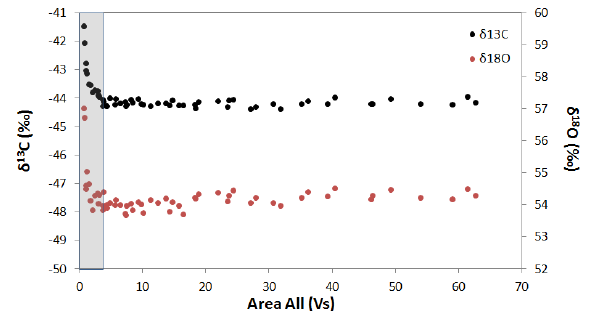
Figure 5. Dilution test: δ 13 C V-PDB (black) and δ 18 O V-SMOW (red) plotted against peak area (area all in Vs). The δ values show a strong non-linearity at peak areas below 4Vs (shaded region). Values be- tween 4 and 15Vs are used to calculate the repeatability of the sys- tem. Figure 6. δ 13 C